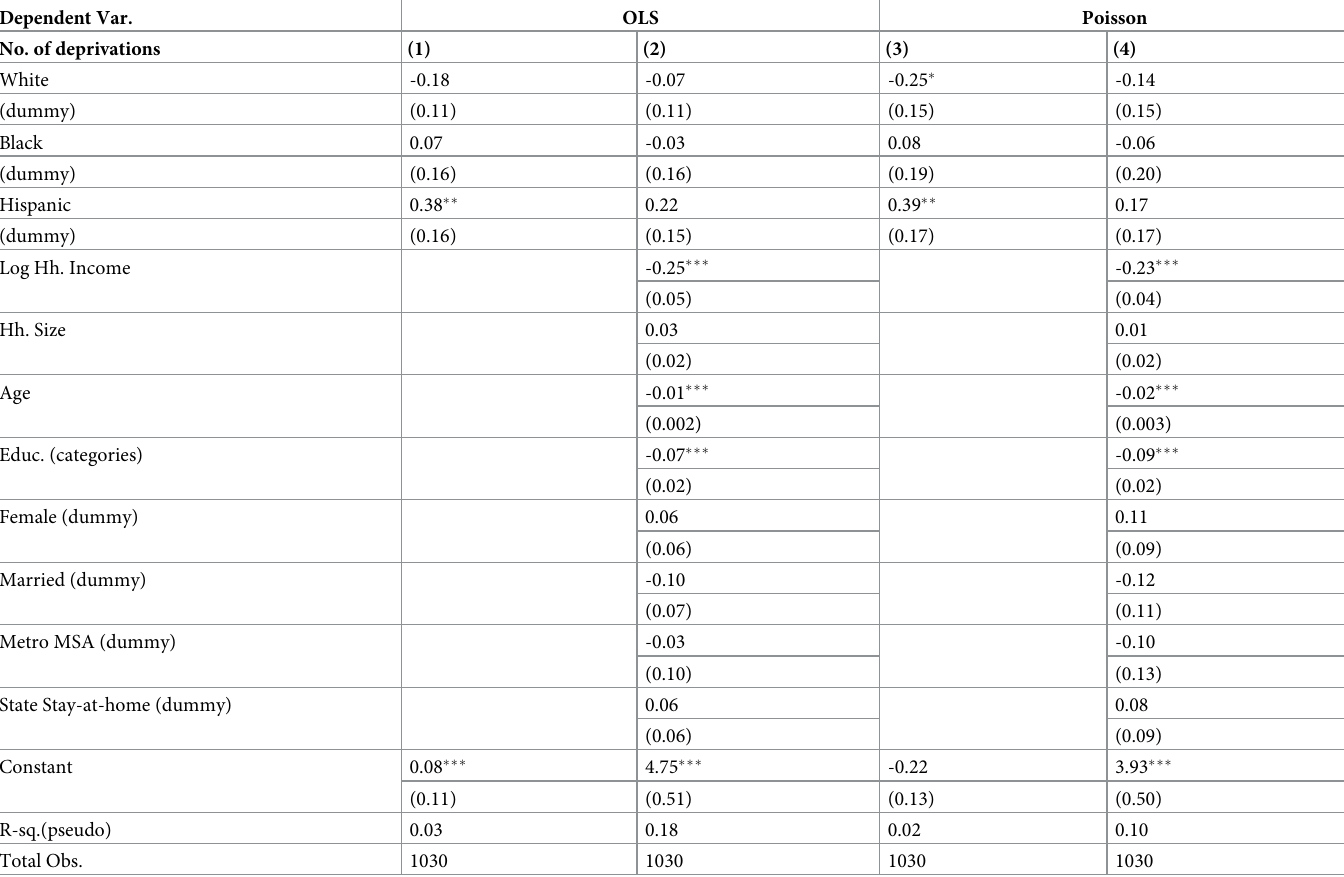
Table 5. Estimates from multivariate regression